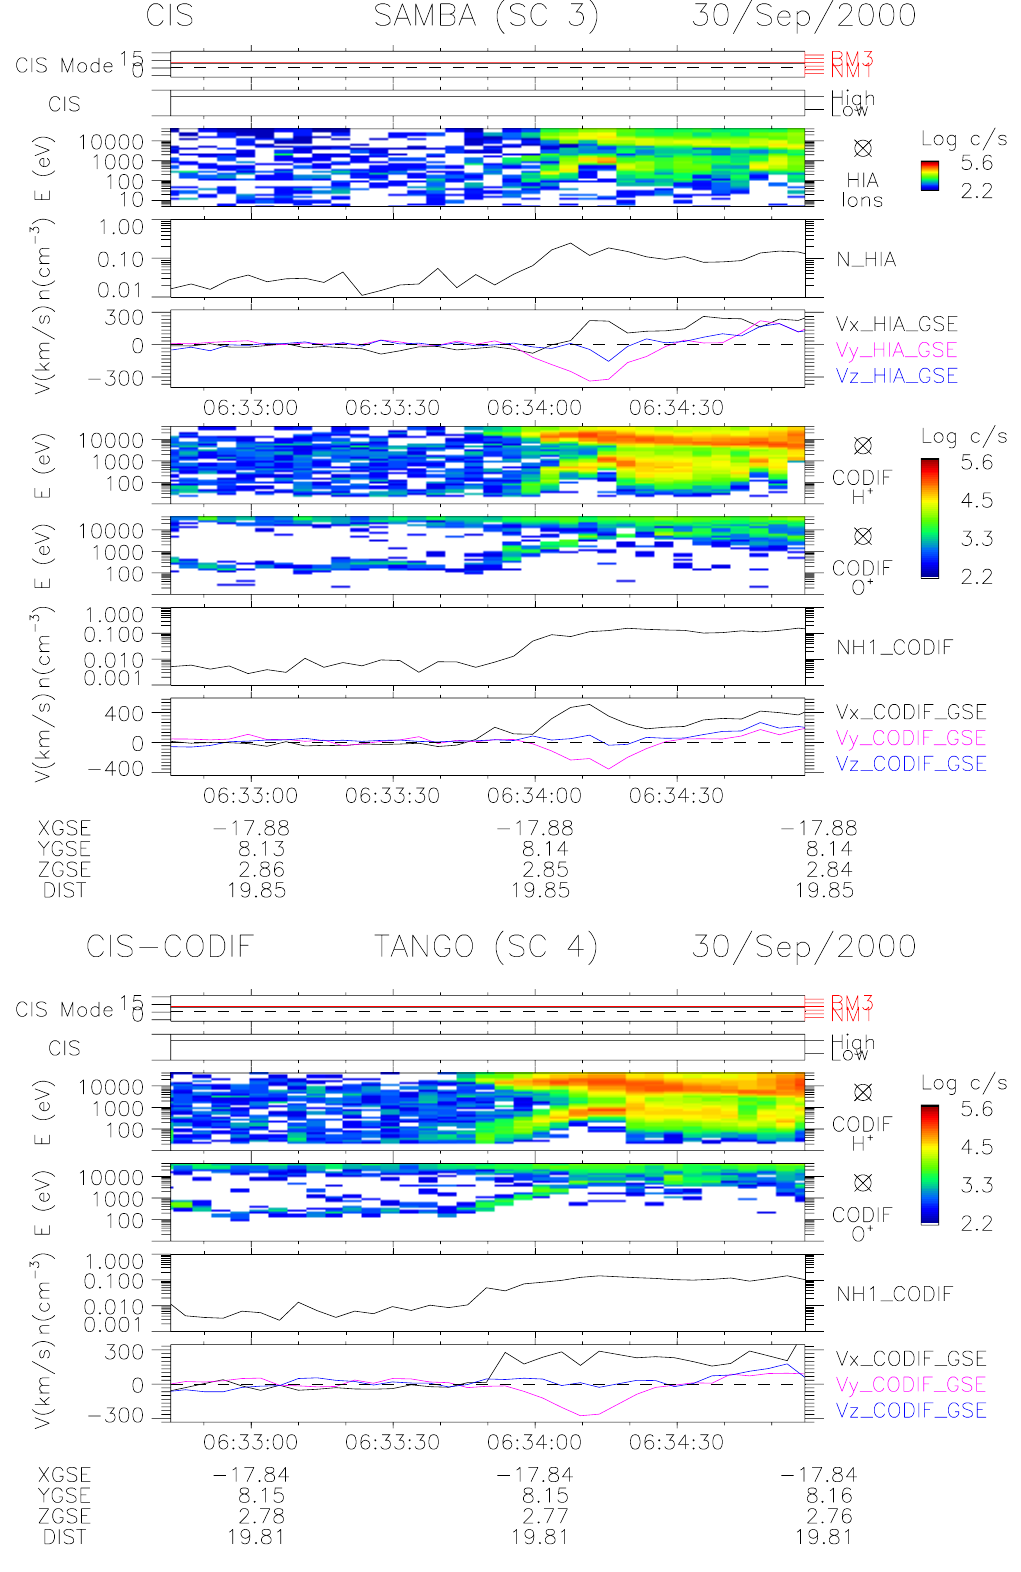
Fig. 24. Simultaneous measurements on 30 September 2000 between 06:32:15 and 06:34:55UT with spacecraft 3 (CODIF and HIA) and spacecraft 4 (CODIF). See caption of Fig. 22 for the description of the